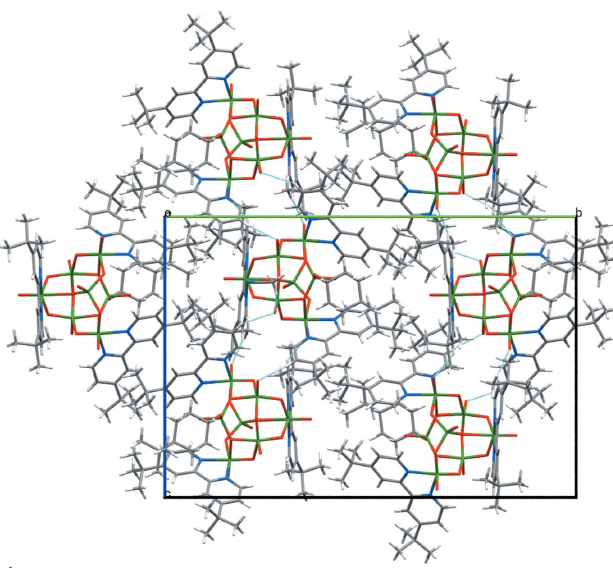
Figure 2 A packing diagram of the title complex viewed along the a axis. The C—